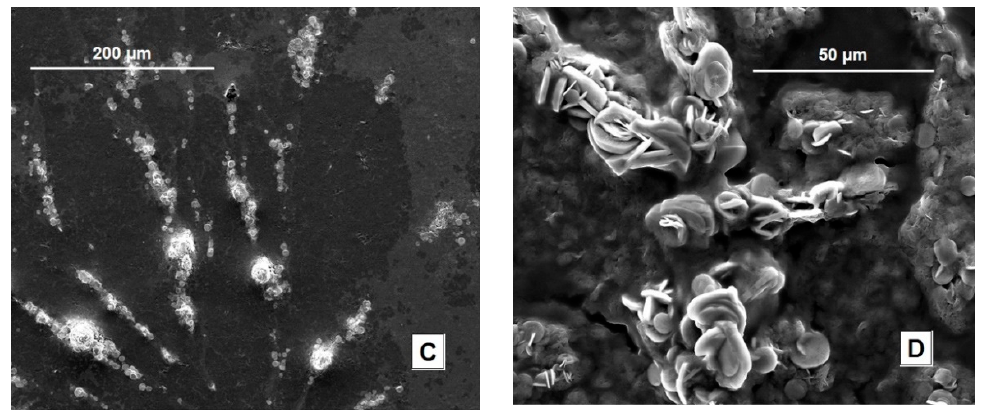
Figure 2. ( A ) Growth curve for the electrochemical deposition of rGO on ITO-PET substrate; ( B ) EDS spectrum of PANI/rGO/ITO-PET; ( C , D ) SEM images of PANI/rGO/ITO-PET electrode.